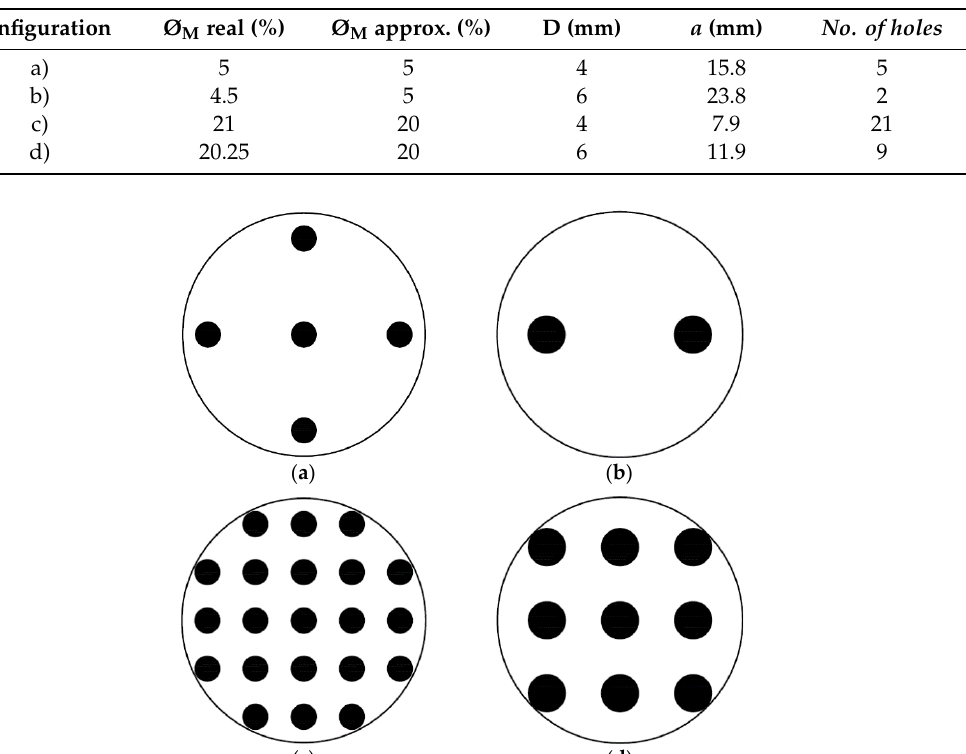
Figure 6. Four different drilling configurations have been measured: ( a ) D = 4 mm, Ø (cid:2897) = 5%, a = 15.8 Figure 6. Four di ff erent drilling configurations have been measured: ( a ) D = 4 mm, ∅ M = 5%, a = 15.8 mm; ( b ) D = 6 mm, Ø (cid:2897) = 5%, a=23.8 mm; ( c ) D = 4 mm, Ø (cid:2897) =20%, a=7.9 mm; and ( d ) D = 6 mm, Ø (cid:2897) = mm; ( b ) D = 6 mm, ∅ M = 5%, a = 23.8 mm; ( c ) D = 4 mm, ∅ M = 20%, a = 7.9 mm; and ( d ) D = 6 mm, 20%, a = 11.9 mm. The radius of all samples is R = 2 cm. ∅ = 20%, a = 11.9 mm. The radius of all samples is R = 2 M